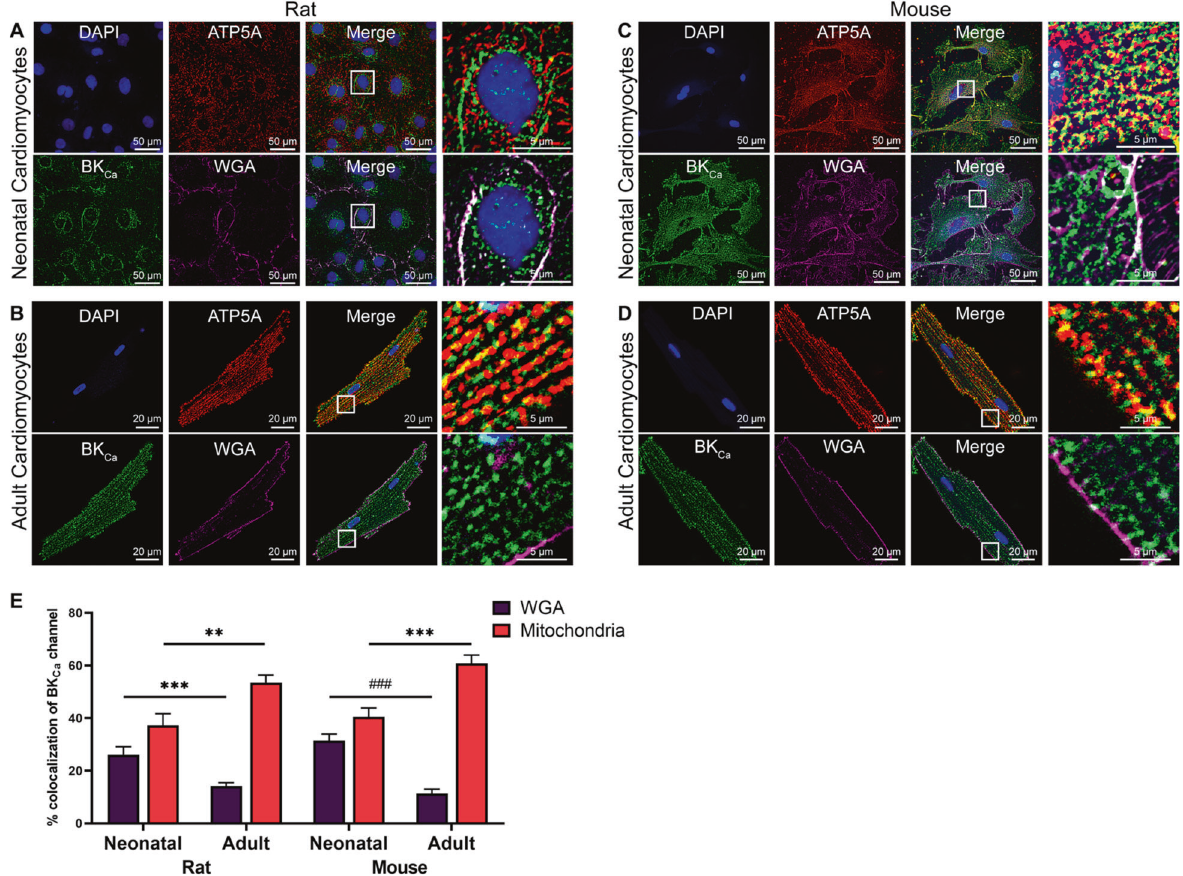
Fig. 1 Localization of native BK Ca channel in neonatal and cardiomyocytes isolated from the rodent heart. A , B , C , and D Isolated cardiomyocytes loaded with WGA (magenta), fi xed, permeabilized, and labeled with BK Ca (green), and ATP5A (red), antibodies. Nuclei were stained with DAPI (blue). The right panels in A , B , C , and D show merged images at higher magni fi cation. E The purple bar represents percentage colocalization between the BK Ca channel and plasma membrane (WGA), which is signi fi cantly higher in neonatal cardiomyocytes compared to adult cardiomyocytes. The red bar represents percentage colocalization between the BK Ca channel and mitochondria, which is lower in neonatal cardiomyocytes as compared to adult cardiomyocytes isolated from rodent hearts. All experiments were repeated independently at least four times and colocalization data are represented as mean ± SEM from 10 cells in each “ n ” number. P -values were determined by a one-tailed paired student ’ s t -test; ** ≤ 0.001, *** ≤ 0.0001, ### ≤ 1.0*10 – 8